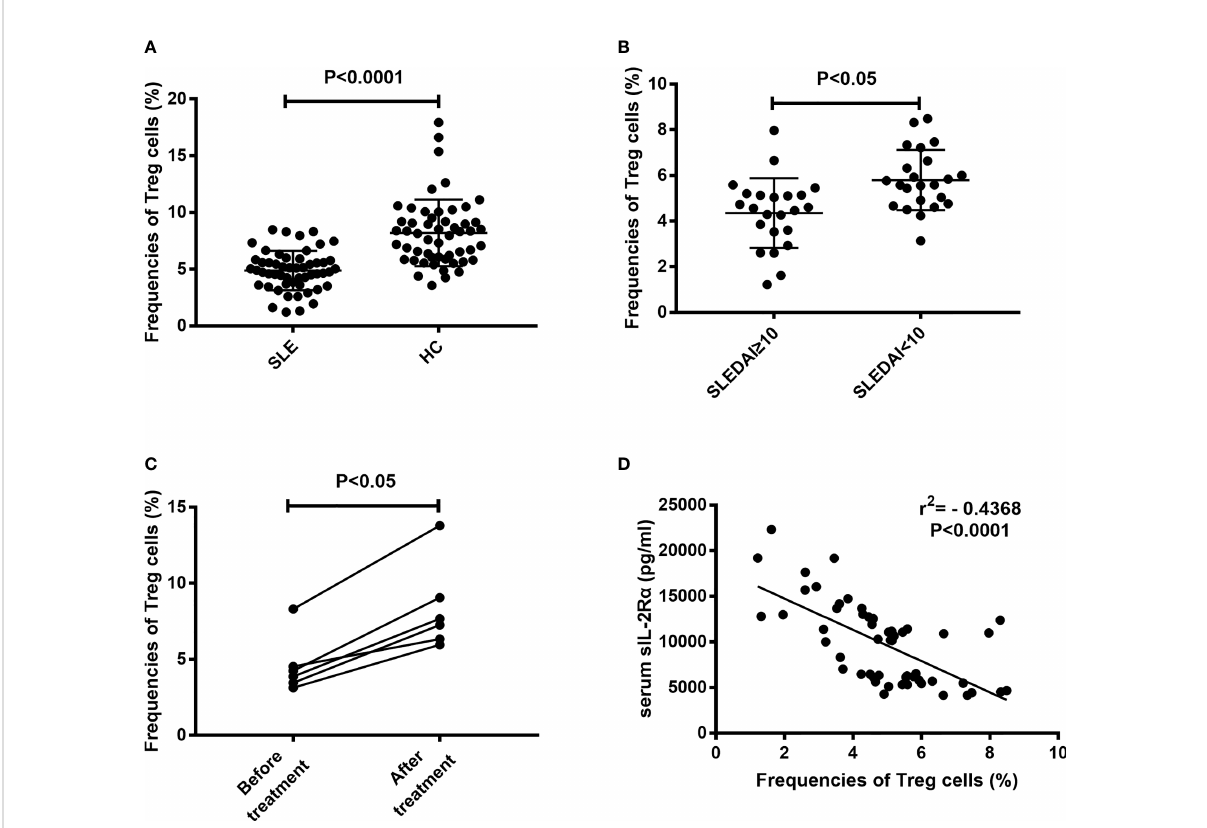
FIGURE 6 Correlation between the frequencies of Treg cells and serum sIL-2R a levels. (A) The frequencies of peripheral CD4 + CD25 + CD127 low/- Treg cells were signi fi cantly lower in SLE patients than those in HCs. (B) The frequencies of peripheral CD4 + CD25 + CD127 low/- Treg cells were signi fi cantly lower in active SLE patients than those in patients with inactive SLE. (C) The frequencies of peripheral CD4 + CD25 + CD127 low/- Treg cells were increased after effective therapy in SLE patients. (D) An inverse correlation between sIL-2R a levels and the frequencies of peripheral CD4 + CD25 + CD127 low/- Treg cells was